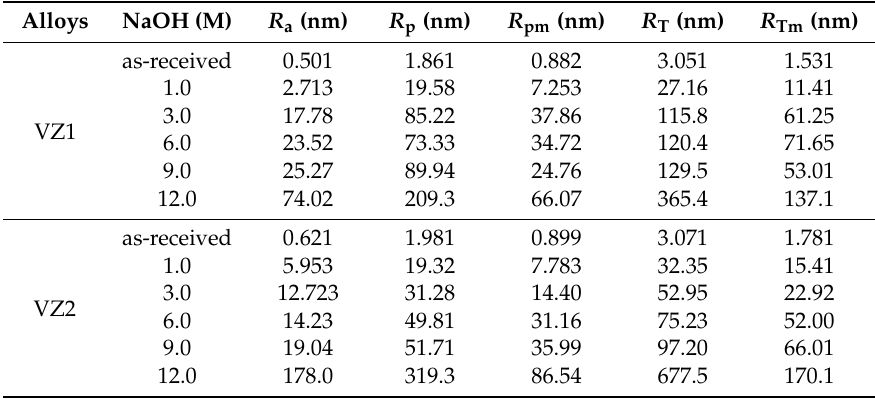
Table 4. Roughness parameters derived from the AFM images for the VZ1 and VZ2 alloys in various concentrations of alkaline solution at 27 ◦